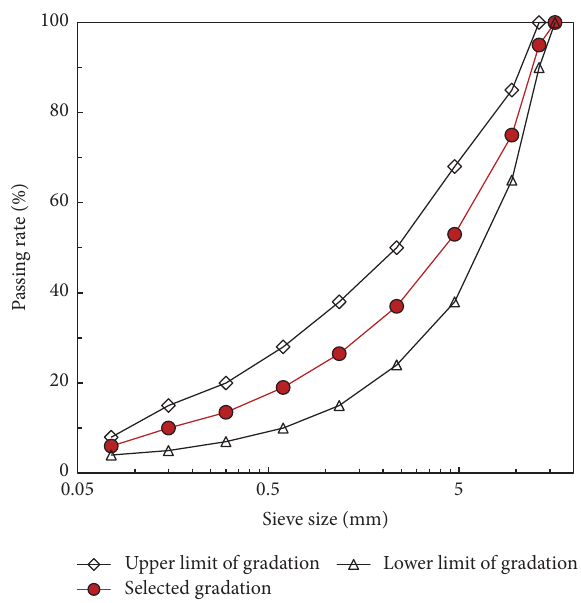
Figure 2: Selected gradation for numerical and experimental tests.